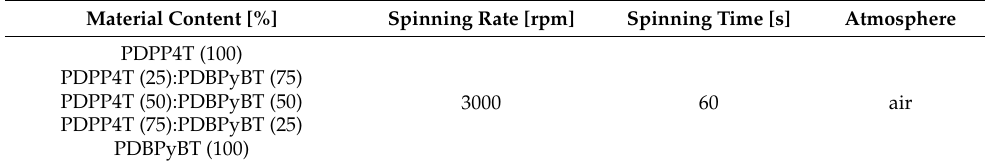
Table 1. Summary of the spin coating parameters and composition of polymer solutions.